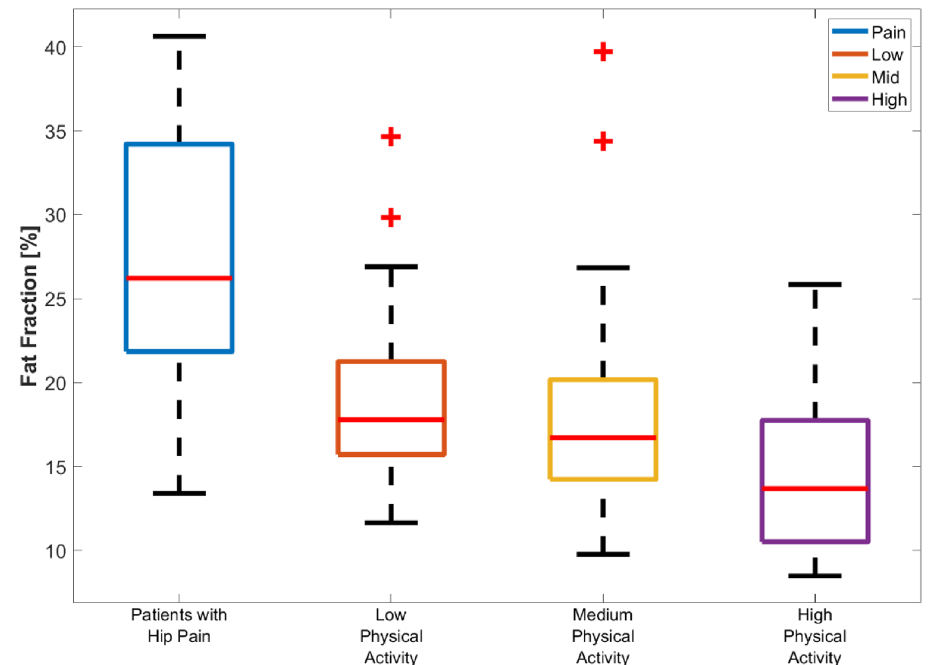
Figure 2. Boxplots of GMAX FF values for each group under study. On each box, the central mark is the median, the edges of the box are the 25th and 75th percentiles. The outliers are plotted individually. The patient group was significantly different to the three HS groups. Among the HS, the low and high activity groups were statistically different ( p < 0.05).